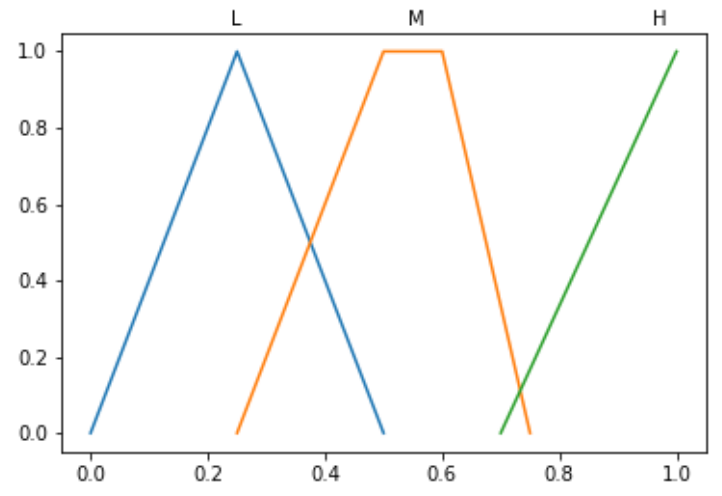
Figure 7. Fuzzy sets for the battery of each